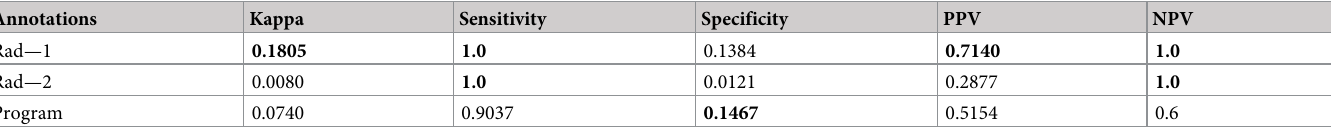
Table 11. Performance level assessment and inter-reader variability analysis using STAPLE-generated consensus